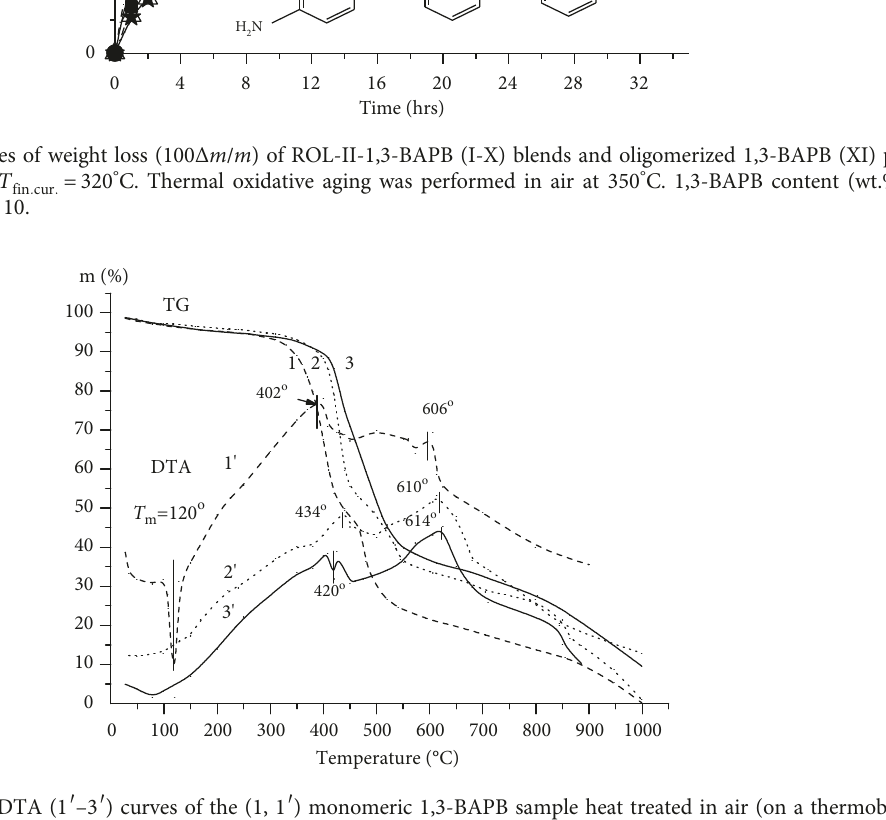
Figure 14: TGA (1 – 3) and DTA (1 ′ – 3 ′ ) curves of the (1, 1 ′ ) monomeric 1,3-BAPB sample heat treated in air (on a thermobalance) at a heating rate of 10 deg · min – 1 , (2, 2 ′ ) ROL-II sample (100%), and (3, 3 ′ ) sample of the ROL-II (75%)-1,3-BAPB (25%) blend, both cured = 320 ° C using the temperature schedule with Т fin cur